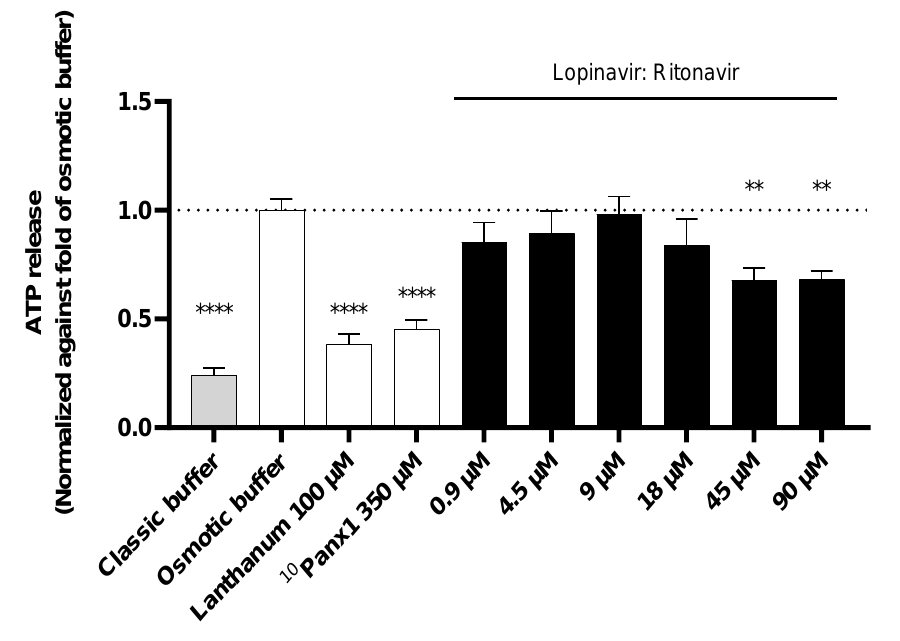
Figure 2. Inhibitory capacity of the drug panel in a Panx1 channel activity assay using transduced Dubca cells overexpressing human Panx1. Panx1 channel opening was triggered via osmotic shock. Extracellular ATP release was measured using a bioluminescence assay and normalised against the osmotic buffer condition. Lanthanum and 10 Panx1 were included as positive controls. Statistical analysis was performed using a non-parametric Kruskal–Wallis test in combination with a Dunn’s test in comparison with the osmotic buffer condition. Data are expressed as mean ± standard deviation, with * p ≤ 0.05; ** p ≤ 0.0; *** p ≤ 0.001 and **** p ≤ 0.0001 ( N = 3, n = 4). ( a ) dexamethasone, remdesivir, ribavirin; ( b ) chloroquine, hydroxychloroquine, favipiravir; ( c ) ritonavir, lopinavir, azithromycin; ( d ) lopinavir: ritonavir in a 4:1 ratio (concentration shown as the final concentration